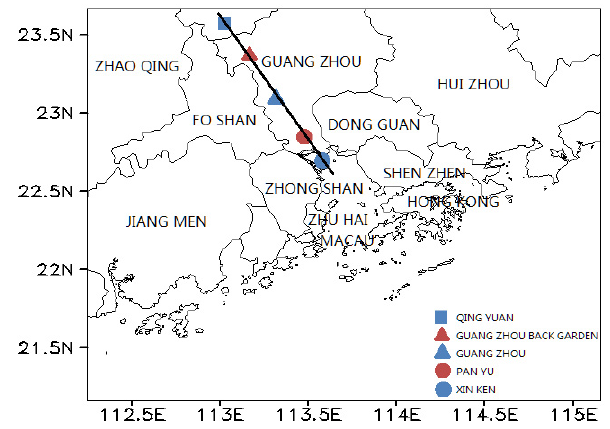
Fig. 1a. Map of Guangdong province and its surroundings.